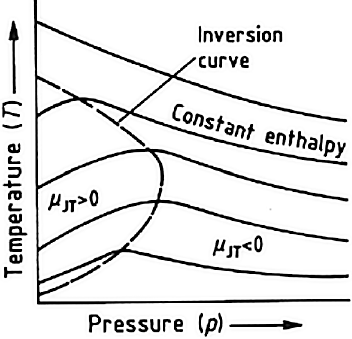
Figure 6. Pressure to temperature chart of a real gas [16].